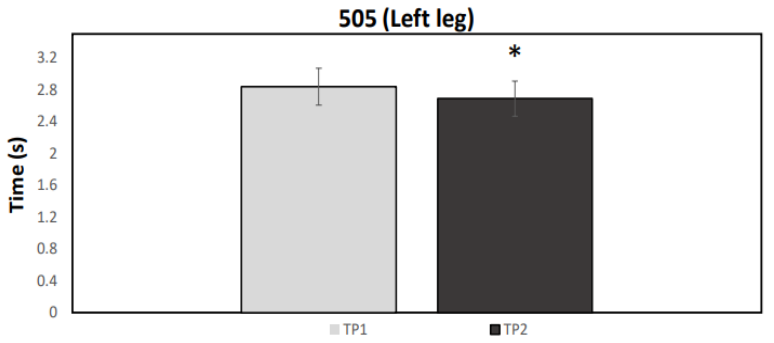
Figure 2. Mean values for the 505 COD test performance for the left leg during the two testing points (TP1 and TP2). * Statistically significant difference ( p < 0.05).